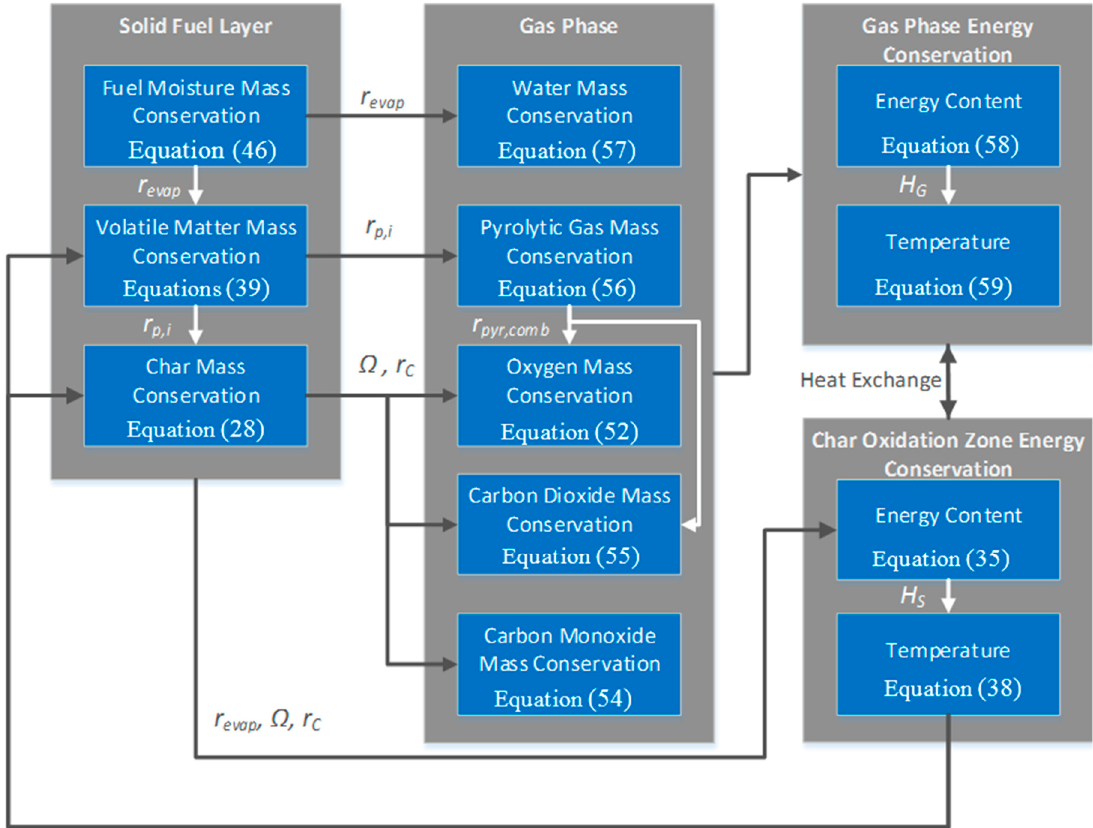
Figure 3. Overview of the model structure.